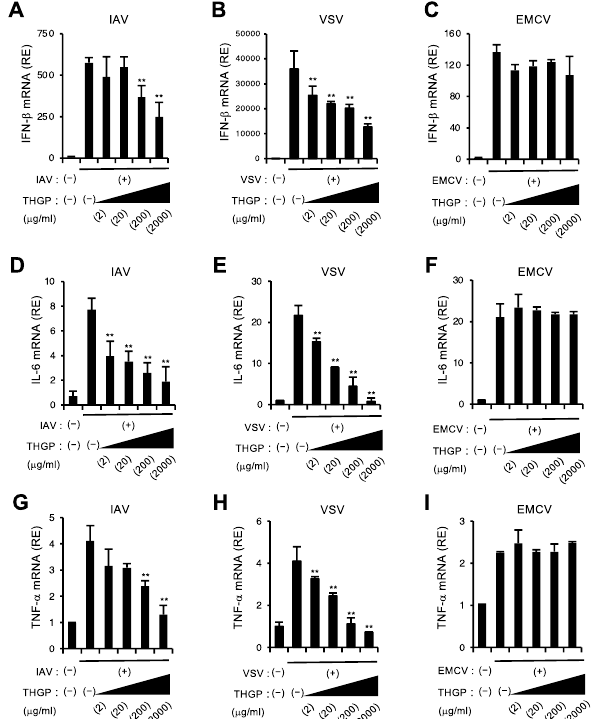
Figure 2. THGP reduces IFN- β induction in response to IAV and VSV but not EMCV infections. ( A – I ) qRT-PCR analysis of IFN- β ( A – C ), IL-6 ( D – F ), and TNF α ( G – I ) mRNA levels at 8 h after infection with control or IAV ( A , D , G ), VSV ( B , E , H ), and EMCV ( C , F , I ) in RAW264.7 cells pretreated with the indicated concentrations of THGP for 24 h. ** p < 0.01 vs. control. Data are presented as mean and s.d. (n = 3) and are representative of at least three independent experiments.